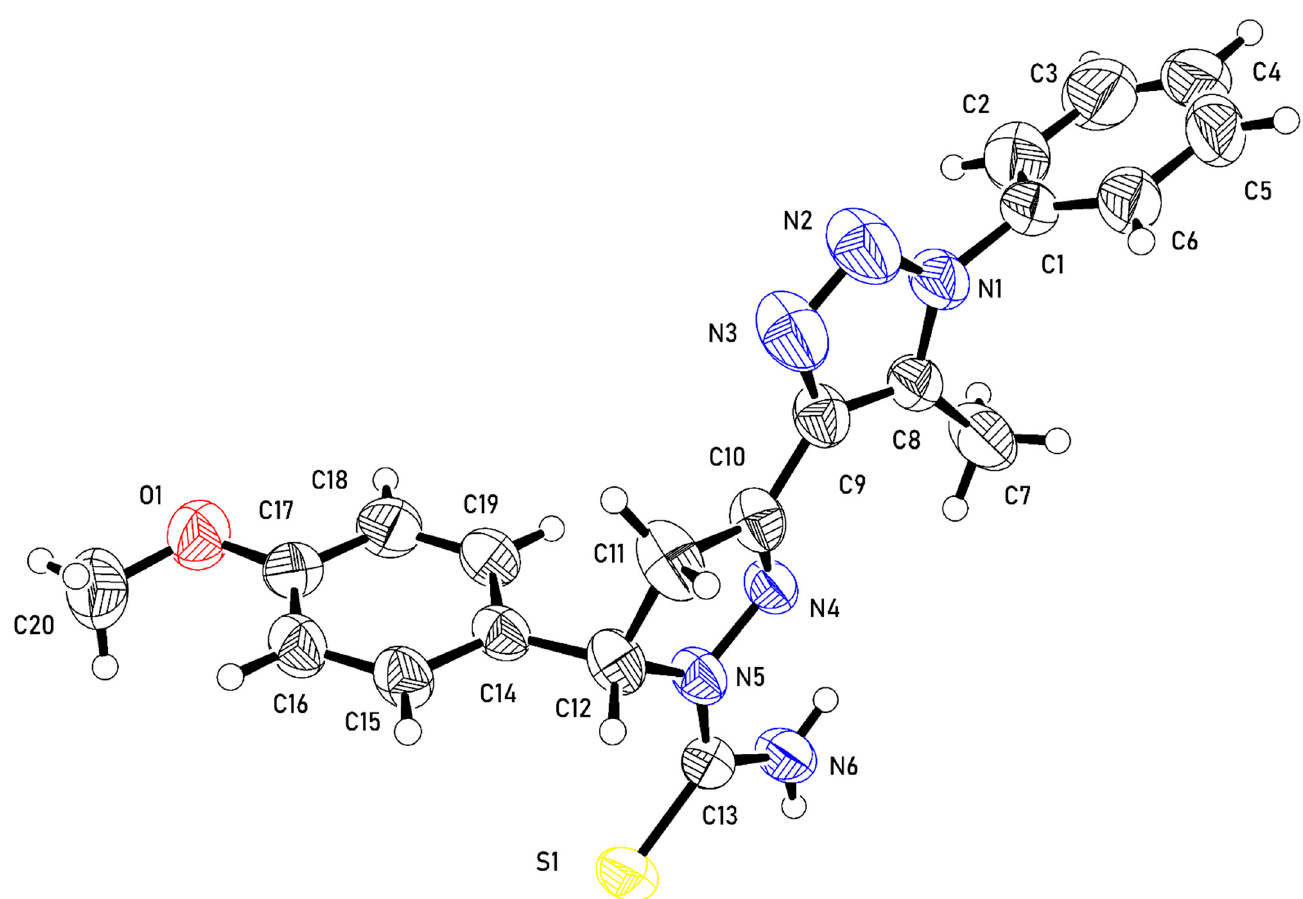
Figure 2. An ortep representation of 4a showing 50% probability atomic displacement ellipsoids.